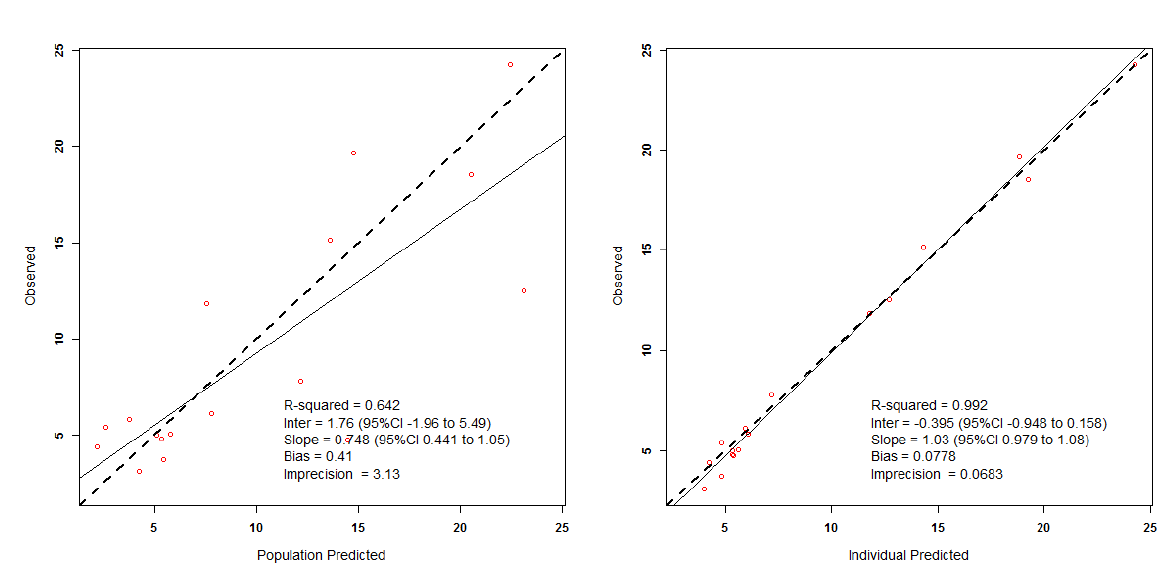
FIGURE 1 - R² value and bias from population (A) and individual (B) observed versus predicted plots obtained from the final model; and the weighted residual plot versus time and concentration